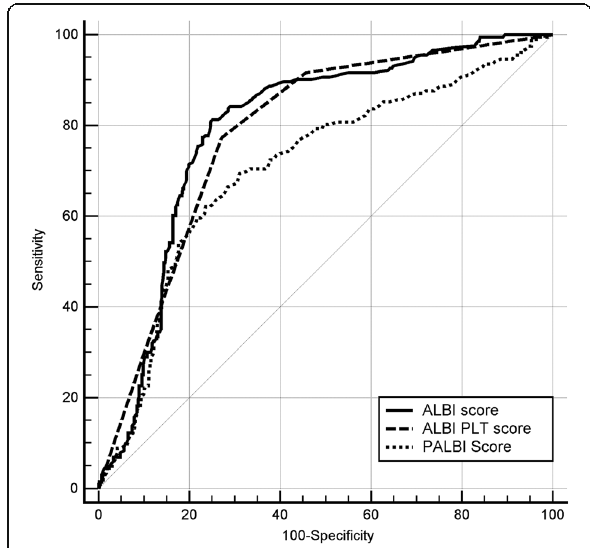
Fig. 2 receiver operating characteristic (ROC) curves analysis of ALBI, ALBI-PLT and PALBI in patients with and without esophageal varices